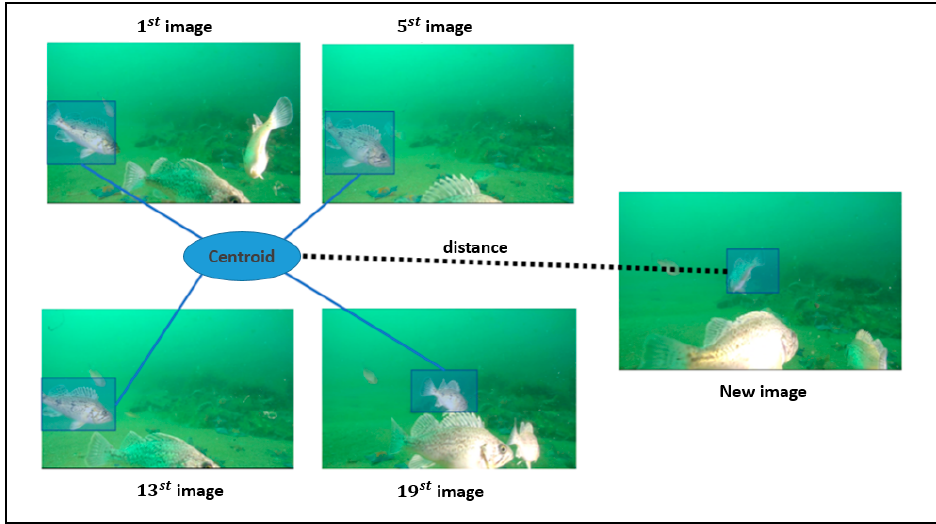
Figure 3. Centroid is calculated as the mean of all samples belonging to each class. When an object is matched, its feature is added to the centroid